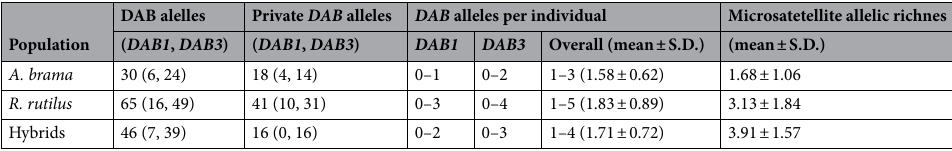
Table 2. Number of DAB alleles in A. brama , R. rutilus and F1 hybrids. The overall number of DAB alleles is calculated for fish which expressed at least one DAB allele. Microsatellite allelic richness is also shown.